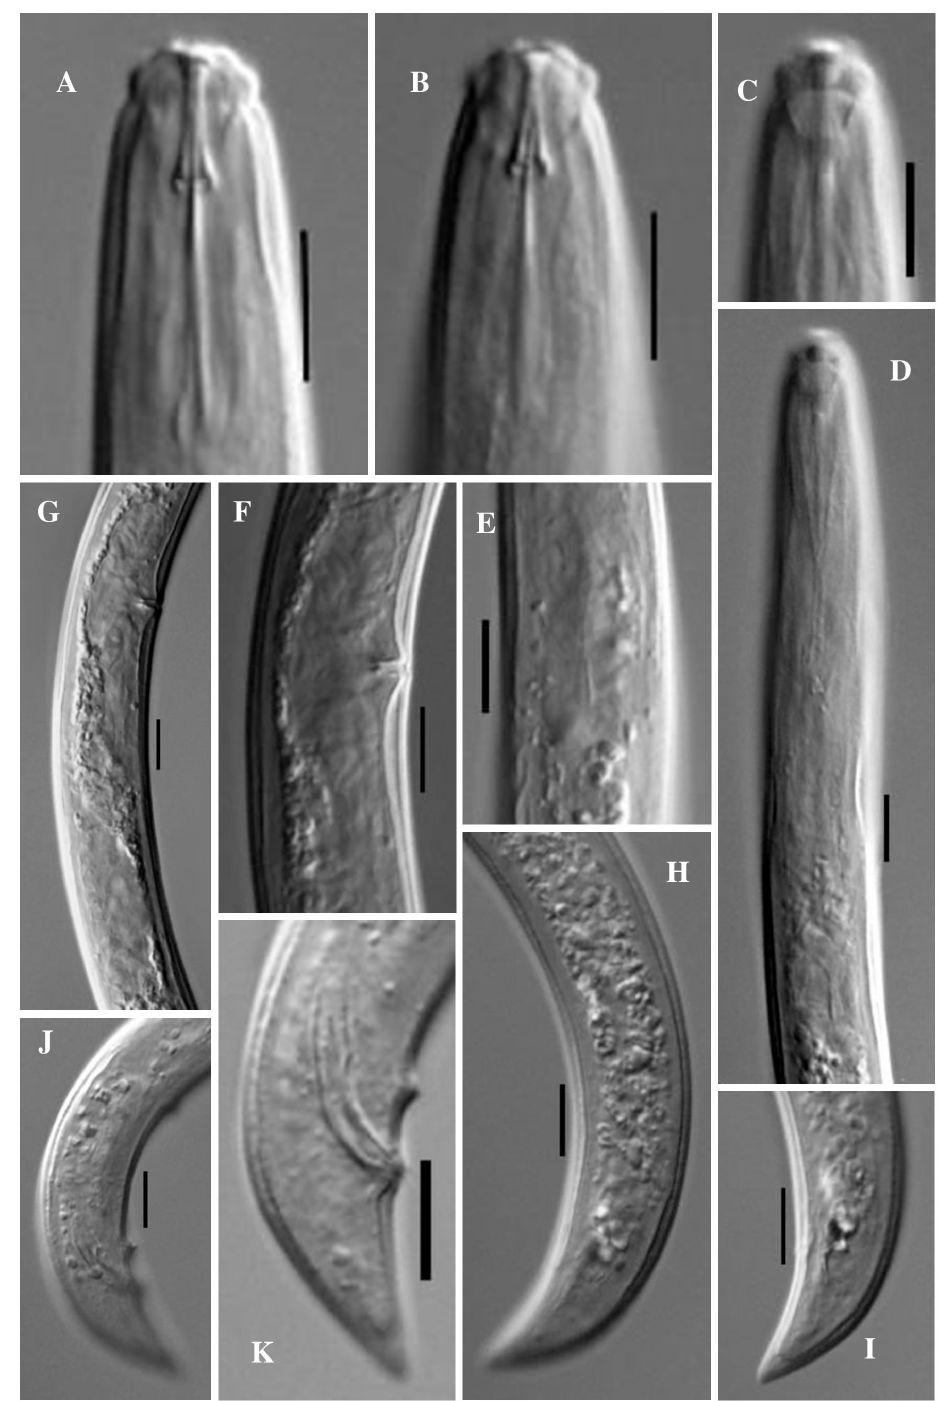
Fig. 9. Basirotyleptus conicaudatus sp. nov. (LM photographs). A, C–I . Holotype, ♀ ( AMU/ZD/ NC/ Basirotyleptus conicaudatus /1 ) . B . Paratype 1, ♀ (AMU/ZD/NC/ Basirotyleptus conicaudatus /2). J–K . Paratype 2, ♂ (AMU/ZD/NC/ Basirotyleptus conicaudatus /2). A–B . Female, anterior region. C . Female, anterior region showing amphid. D . Female, pharyngeal region. E . Female, pharyngeal bulb. F–G . Female, genital system. H . Female, posterior region. I . Female, posterior end. J–K . Male, posterior end. Scale bars = 10